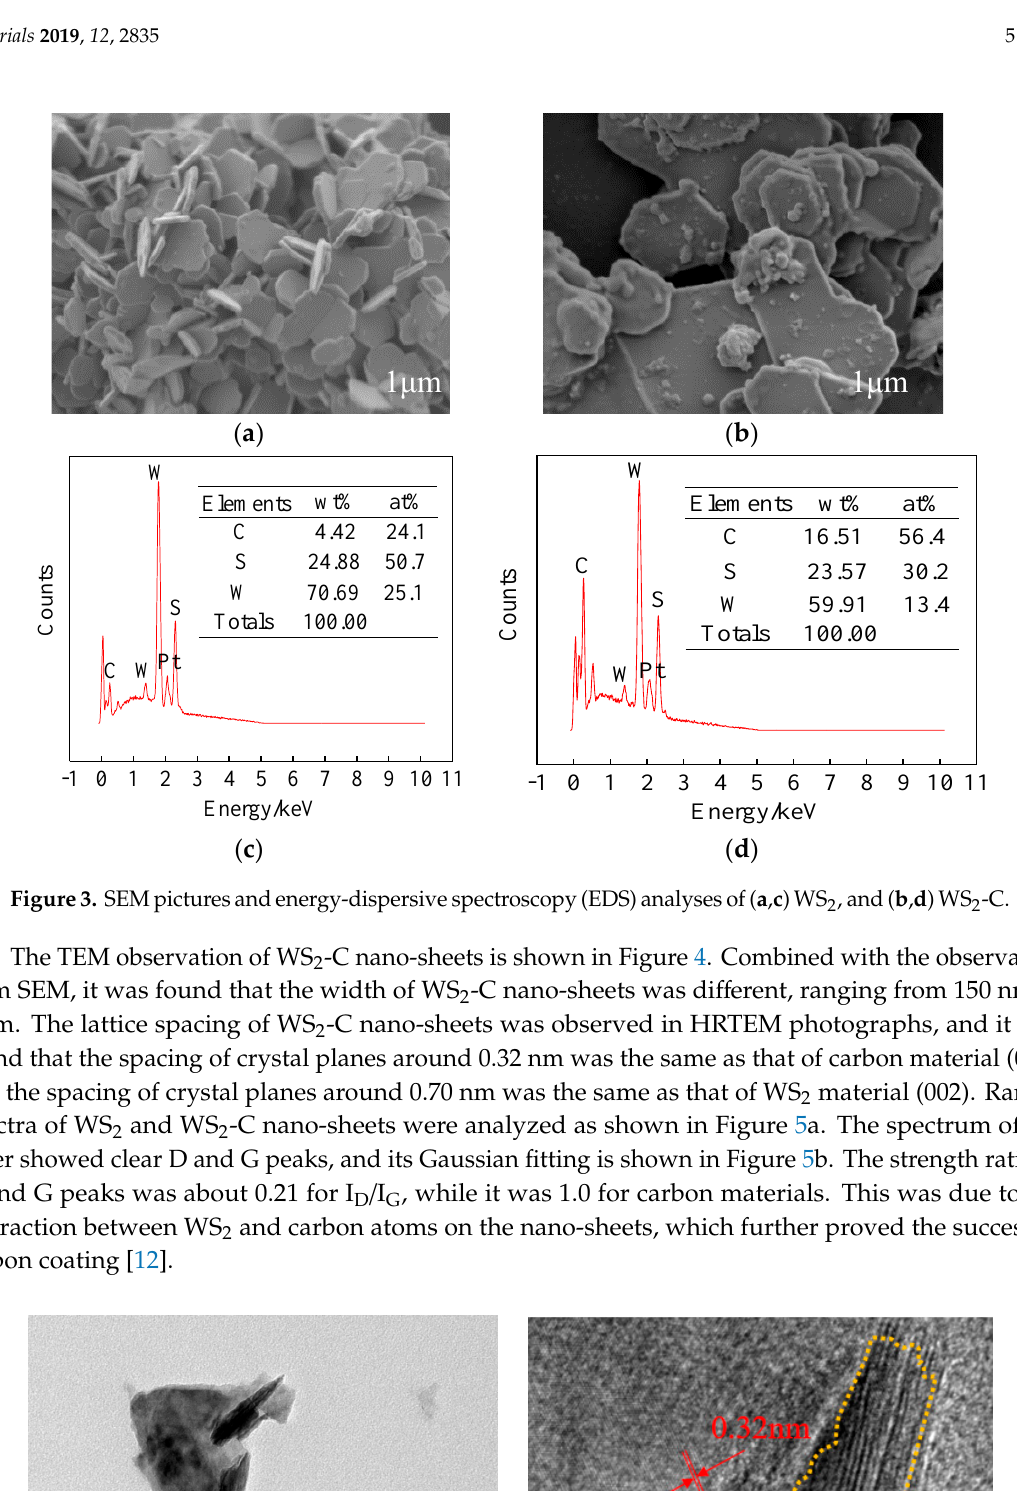
Figure 4. Micro-morphology of WS 2 -C nano-sheets from ( a ) TEM, and ( b ) high-resolution TEM (HRTEM).